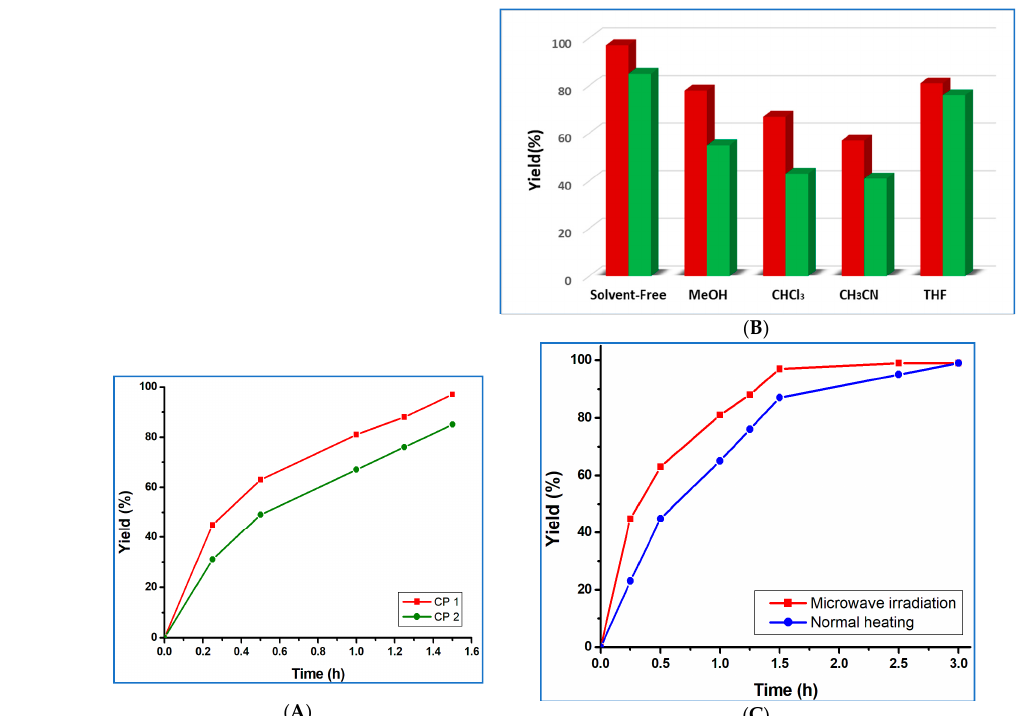
Figure 5. ( A ) Plot of yield vs. time for the microwave-assisted solvent-free cyanosilylation reaction of benzaldehyde, catalyzed by 1 or 2 . ( B ) Yield of cyanosilylation of benzaldehyde in different solvents catalyzed by compounds 1 (red pillar) and 2 (green pillar). ( C ) Plots of yield vs. time for the microwave-assisted (red line) and normal-heating (blue line) solvent-free cyanosilylation reaction of benzaldehyde, catalyzed by 1